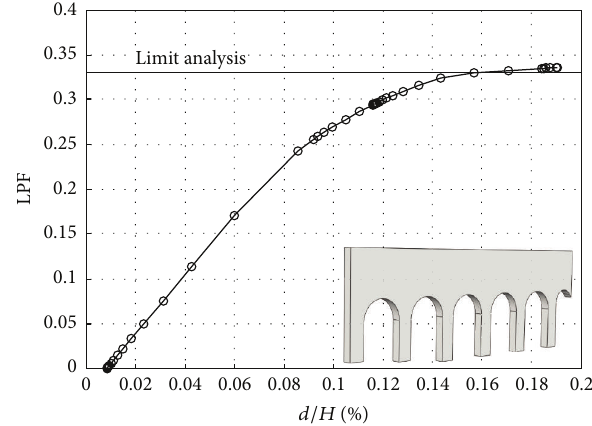
Figure13:Mechanism2:comparisonbetweennonlinearFEanalysis and limit analysis for the out-of-plane collapse of the fac¸ade considering the contribution of peripheral lateral walls.